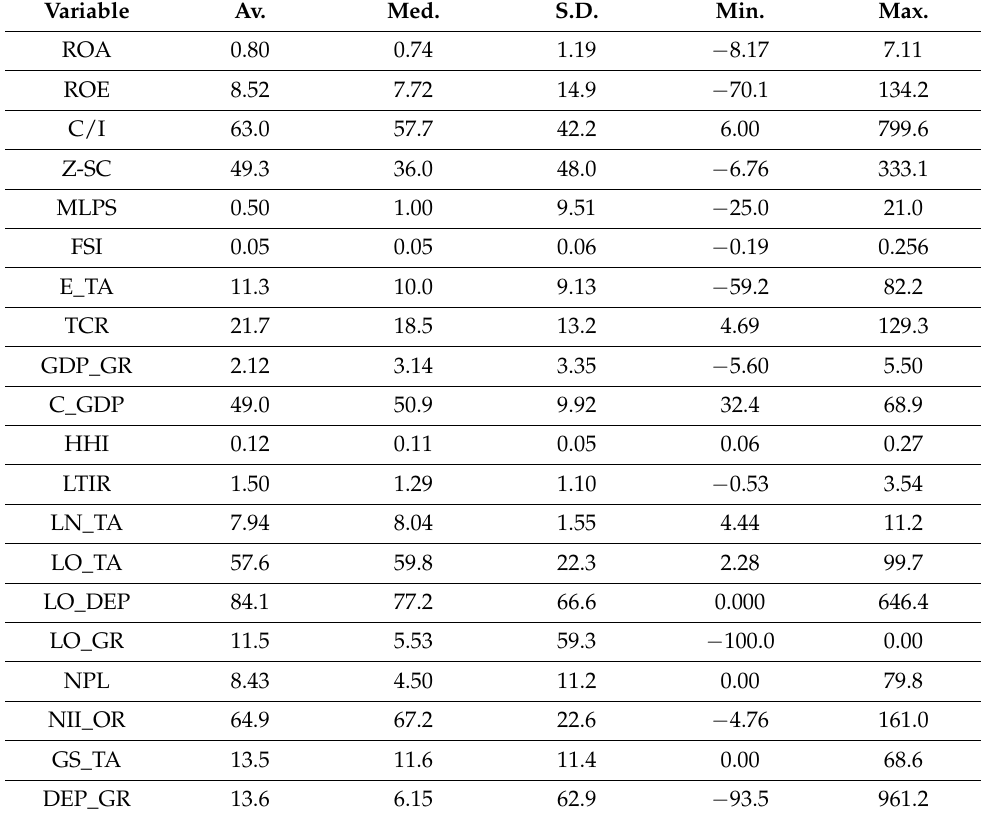
Table A3. Descriptive